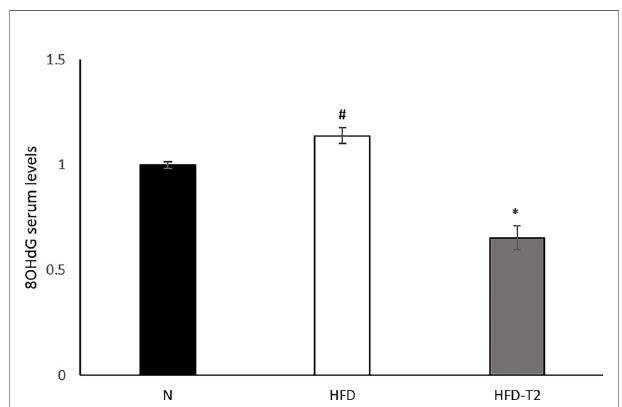
FIGURE 8 | Effects of T2 administration on 8-OHdG serum levels. 8-OHdG was detected by a competitive Enzyme Linked-Immunosorbent Assay (ELISA) in serum of N, HFD, HFD-T2 rats. The histograms represent means ± SEM of fi ve independent experiments (n = 5), *P < 0.05 vs. HFD and # P < 0.05 vs. N. N: rats receiving a standard diet for 14 weeks; HFD: rats receiving a HFD for 14 weeks; HFD-T2: rats receiving a HFD for 14 weeks with a daily administration of T2 during the last 4